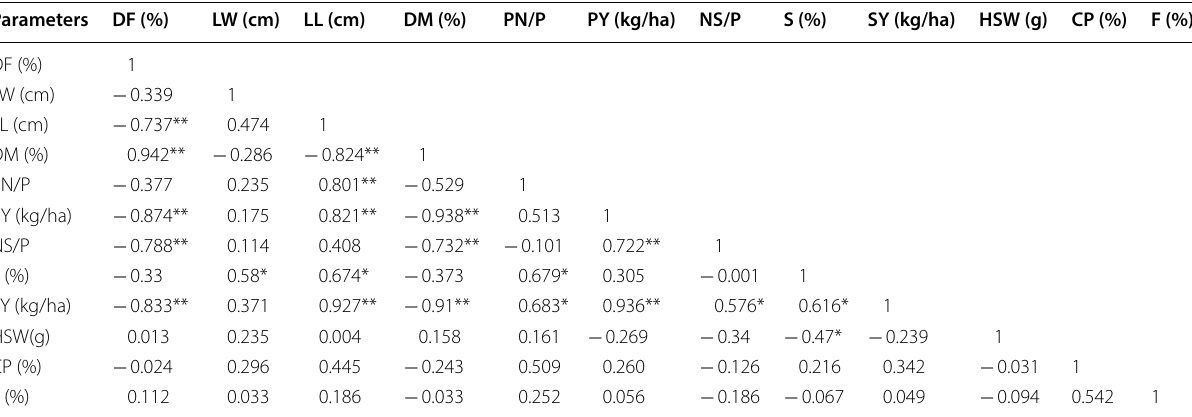
* and ** significant at p < 0.05 and p < 0.01, respectively and numbers with no * are non-significant. DF (%) length, DM